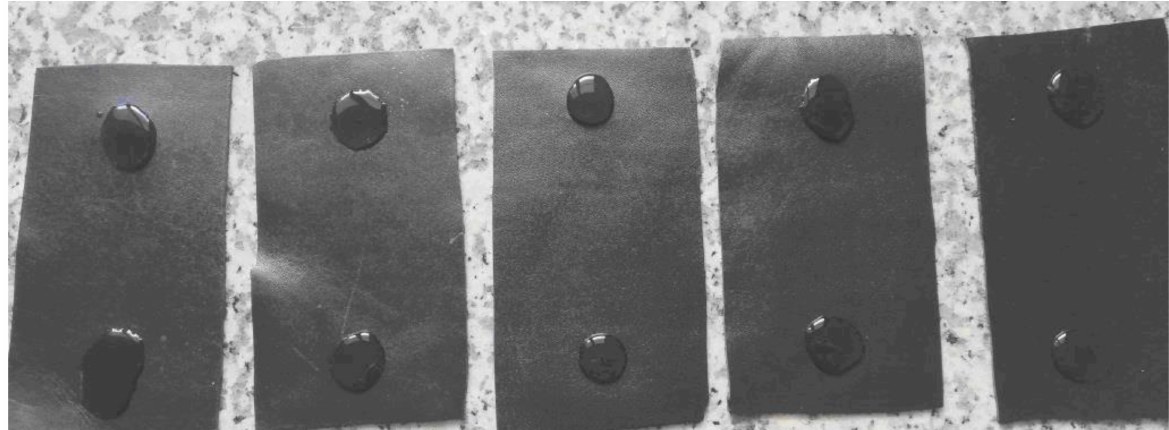
Figure 6. The images of the leather specimens during water spotting test after 30 min. (Samples from left to right: DS 90/10, DS 80/20, DS 75/25, DS 60/40, DS